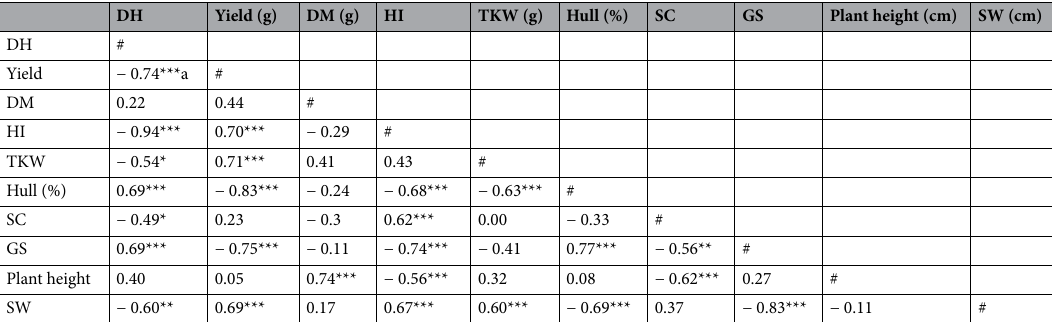
Table 2. Pearson correlation matrix of phenotypic and yield components measured in a block design experiment 2016–17. Days to heading (DH), Yield (g), Dry matter (DM), harvest index (HI), Thousand